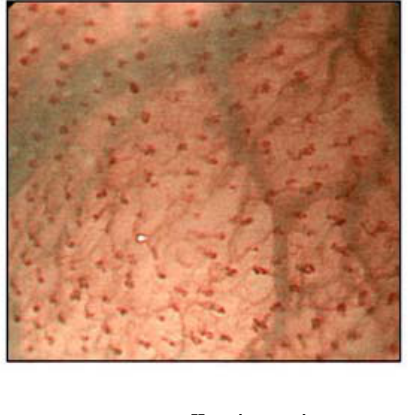
FIGURE 3 - Esophago-gastric junction; squamous epithelium in the distal esophagus; narrow-band imaging coupled to Magnification. The dark brown dots correspond to the top of the intrapapillary capillary loops. The larger vessel colored in cyan is a collecting vein more in